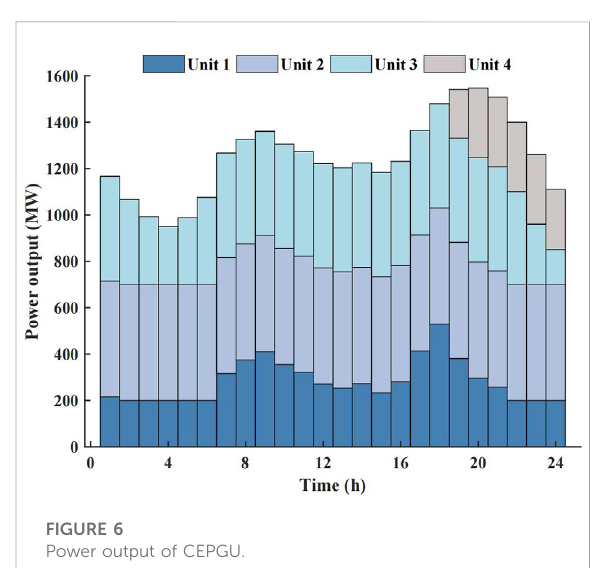
FIGURE 6 Power output of CEPGU.